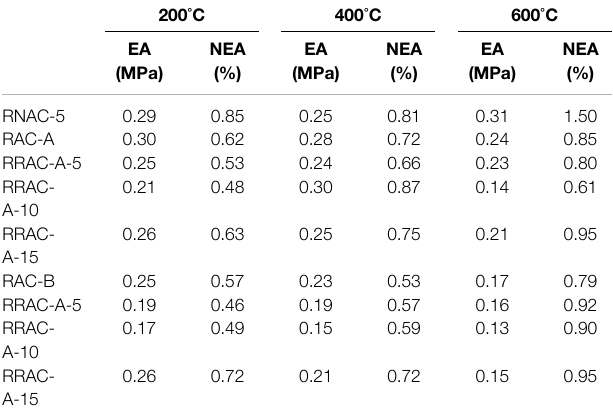
TABLE 9 | Energy absorption (EA) and normalized energy absorption (NEA) after